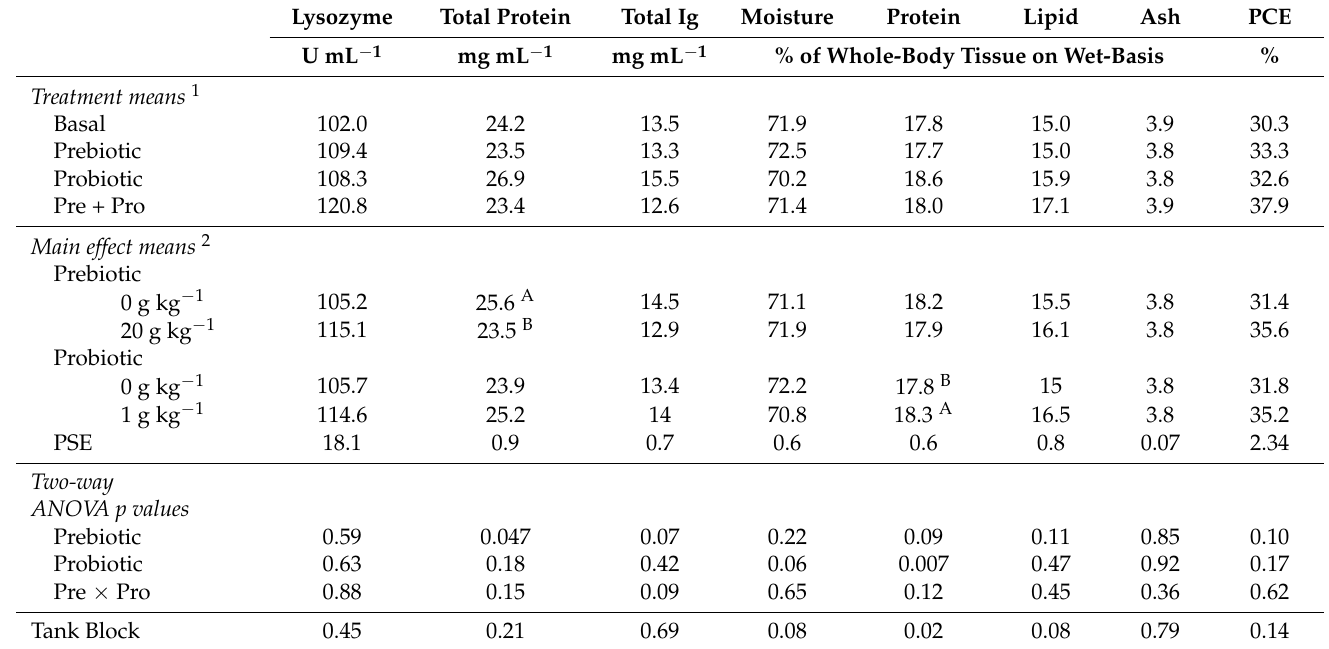
Table 3. Immunological responses in the red drum plasma, whole-body proximate composition, and protein conversion efficiency (PCE) after fish were fed the experimental diets for 8 weeks.